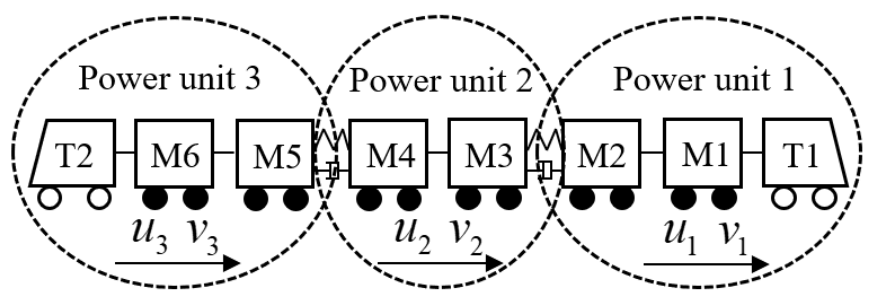
Figure 2. Distribution diagram of CRH380A EMUs power